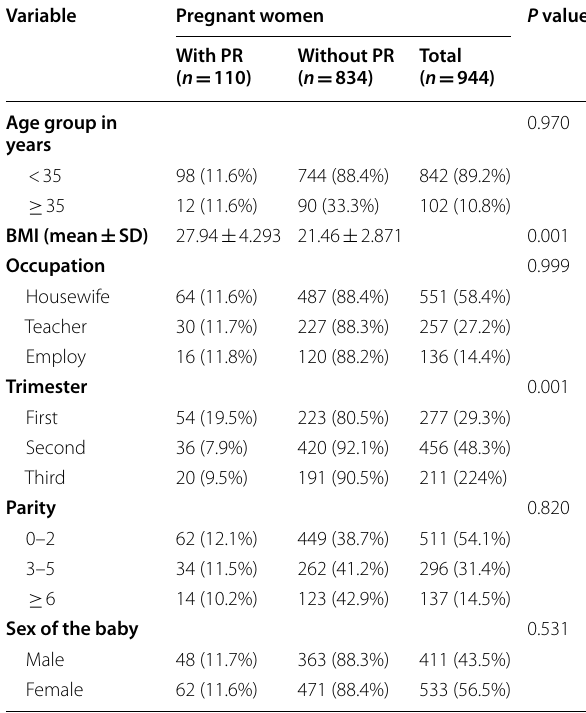
Table 1 Frequency of the associated features with nasal obstruction of the PR in 110 pregnant women Feature